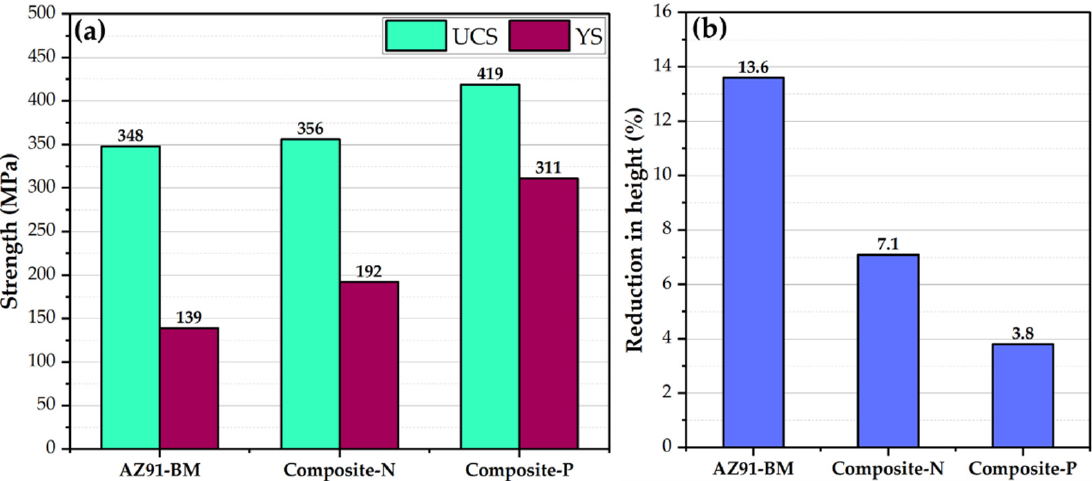
Figure 5. ( a ) Ultimate compressive strength and yield strength and ( b ) reduction in the height of the compression tested AZ91 matrix alloy and the composites.